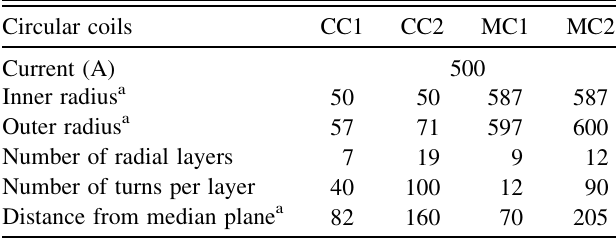
FIG. 5. Flutter of the magnetic field as a function of radius.